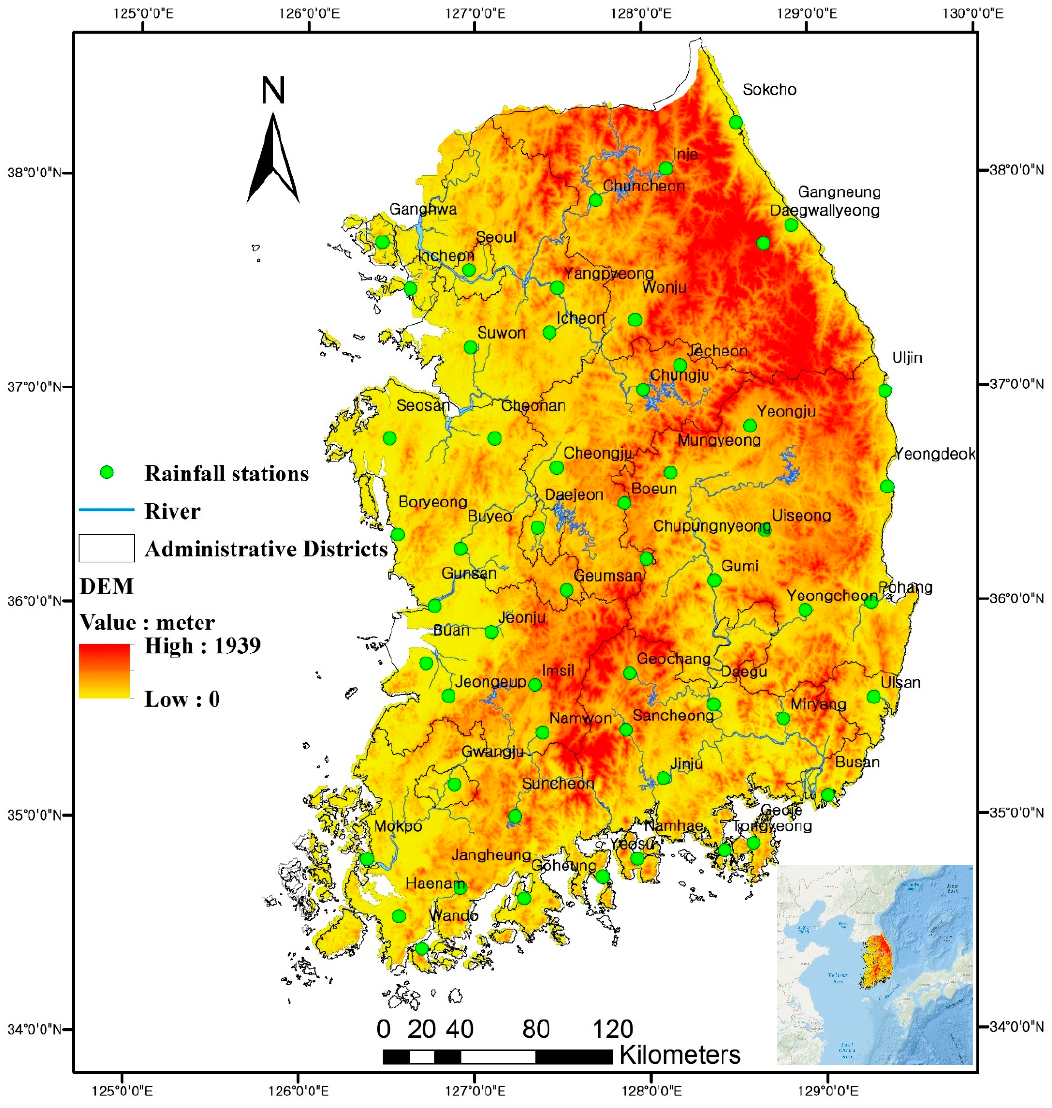
Figure 1. Geographical distribution of the administrative district boundaries, rivers, topographical characteristics of the 55 rainfall stations used in this study.